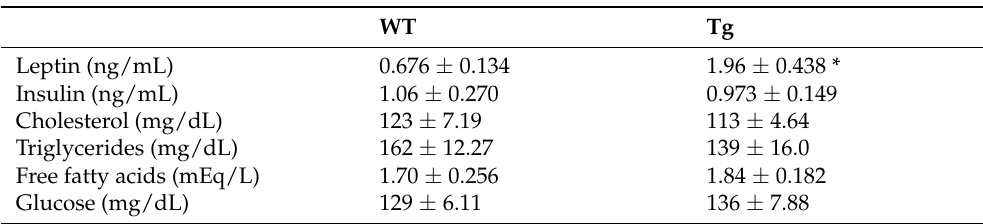
Table 1. Serum biochemical parameters. All statistical analyses were performed using Mann-Whitney U test. Each value represents the mean ± SEM ( n = 5–7). Asterisk indicates a statistically significant difference (* p < 0.05). WT Tg Leptin (ng/mL) 0.676 ± 0.134 1.96 ± 0.438 * Insulin (ng/mL) 1.06 ± 0.270 0.973 ± 0.149 Cholesterol (mg/dL) 123 ± 7.19 113 ± 4.64 Triglycerides (mg/dL) 162 ± 12.27 139 ± 16.0 Free fatty acids (mEq/L) 1.70 ± 0.256 1.84 ±